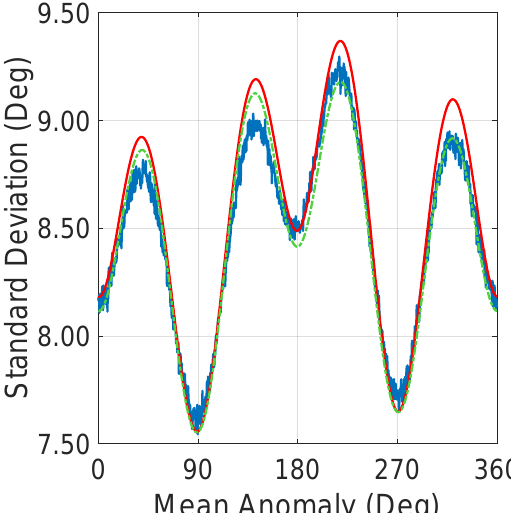
Figure 2. The standard deviation of estimated quadratic phase error (QPE) result from Monte Carlo numerical simulation ( blue ), the monostatic analytical approximation model (MonoAAM) (dashed green ), and the BiAAM ( red ). The fluctuating blue line of the numerical simulation result shows the influence of random error samples. The result indicates that the maximum of the standard deviation of the estimated QPE from the BiAAM is greater than that from Monte Carlo numerical simulation for all the mean anomalies M ∈ [ 0,2 π ] , while the estimations from the MonoAAM cannot guarantee the same